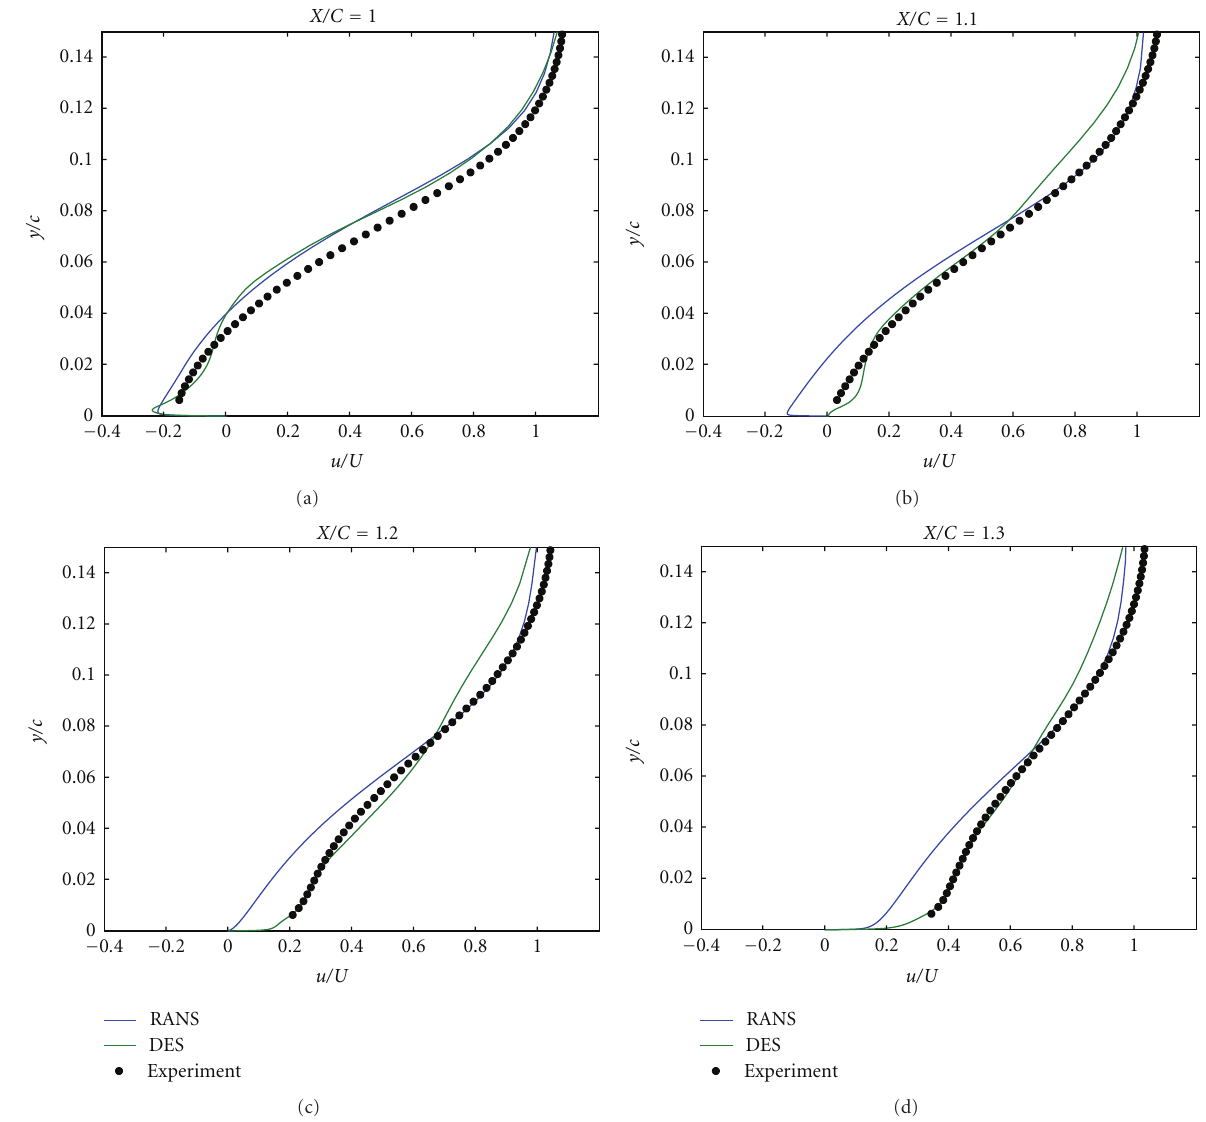
Figure 10: Mean U -velocity profile comparison at x = (a) 1 . 0, (b) 1 . 1, (c) 1 . 2, and (d) 1 .